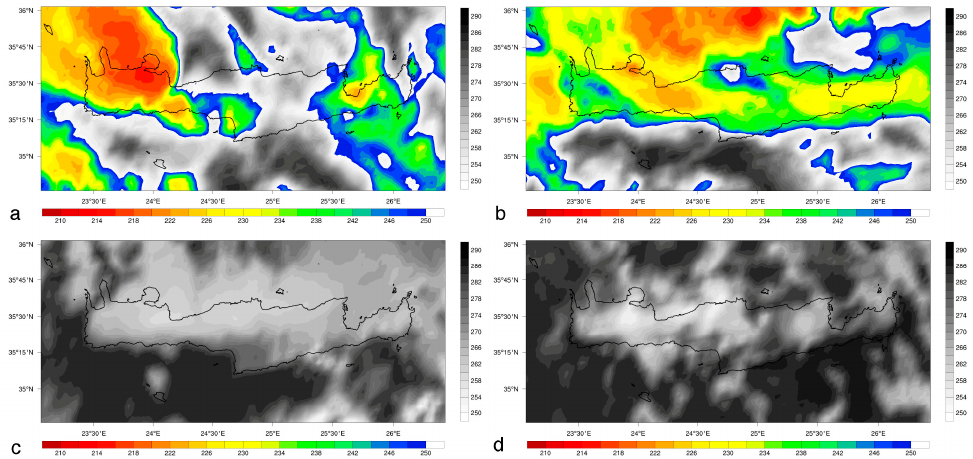
Figure 11. METEOSAT infrared brightness temperature (IR 10.8 µ m), valid ( a ) at 2230 UTC 13 February 2019, ( b ) at 0600 UTC 14 February 2019, ( c ) 0000 UTC 15 February 2019, and ( d ) at 1200 UTC 15 February 2019. Cloud top brightness temperatures colder than 250 K are colored.